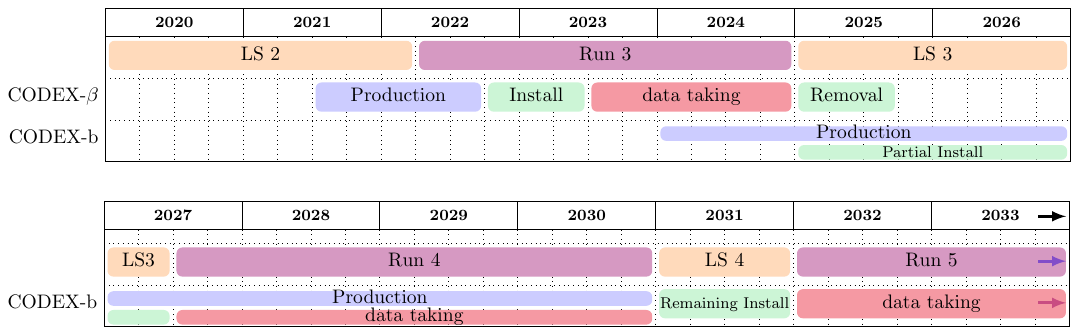
Fig. 5 Approximate production, installation and data-taking timelines for demonstrator (CODEX- β ) and full (CODEX-b) detectors. (Updated according COVID to